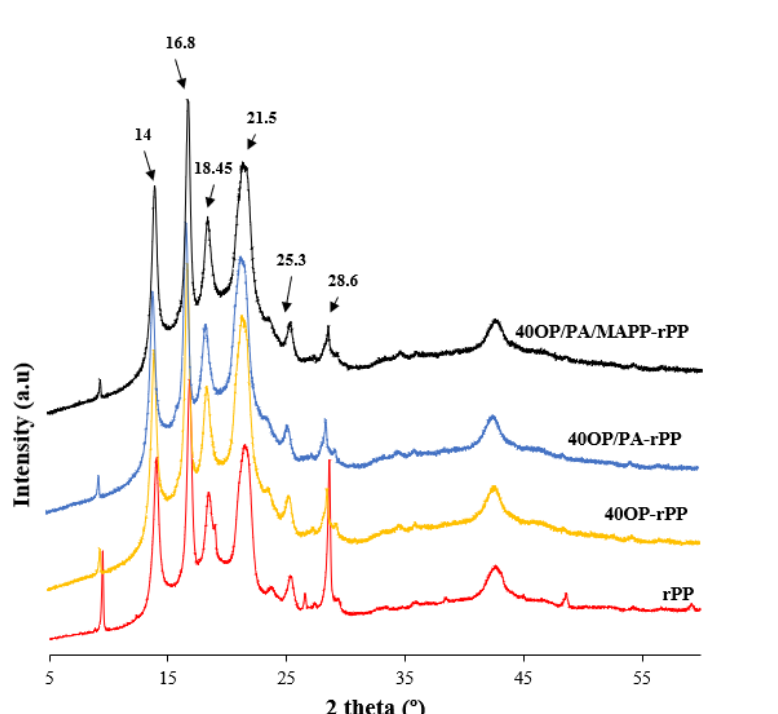
Figure 13. Diffraction diagram obtained as a result of the XRD analysis performed on the rPP and the different composites.